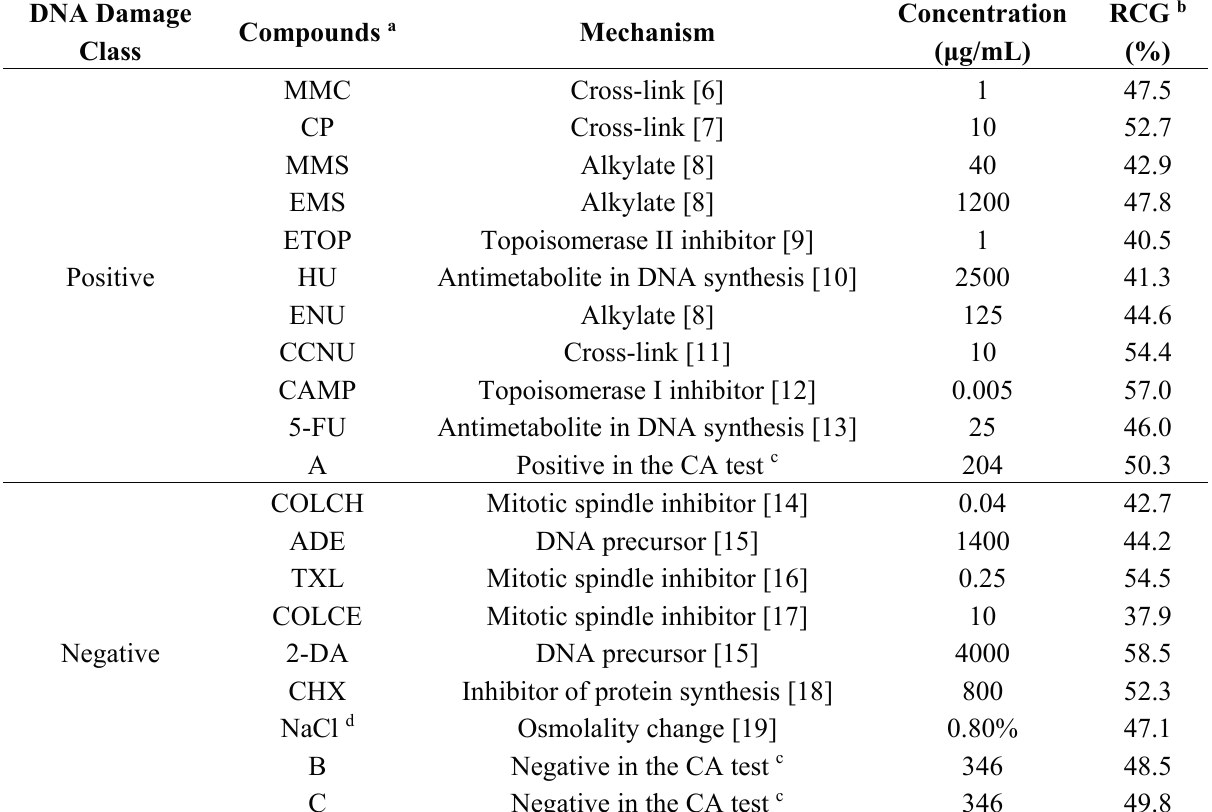
Table 1. A list of compounds used in the validation